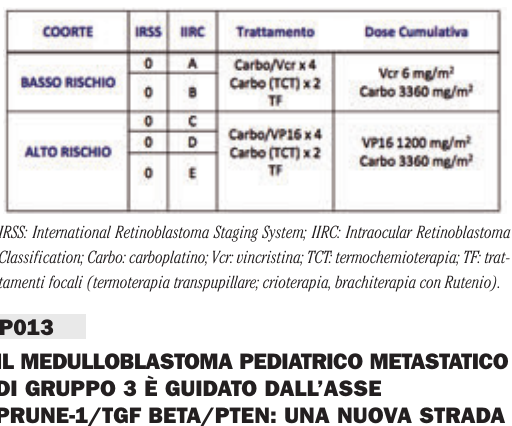
Tabella 1. Schema di trattamento